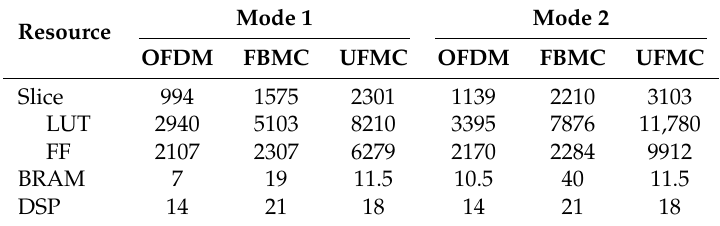
Table 5. Resource utilization for the implemented baseband modulator cores and comparison with other related